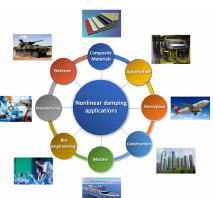
Figure 14. Nonlinear damping